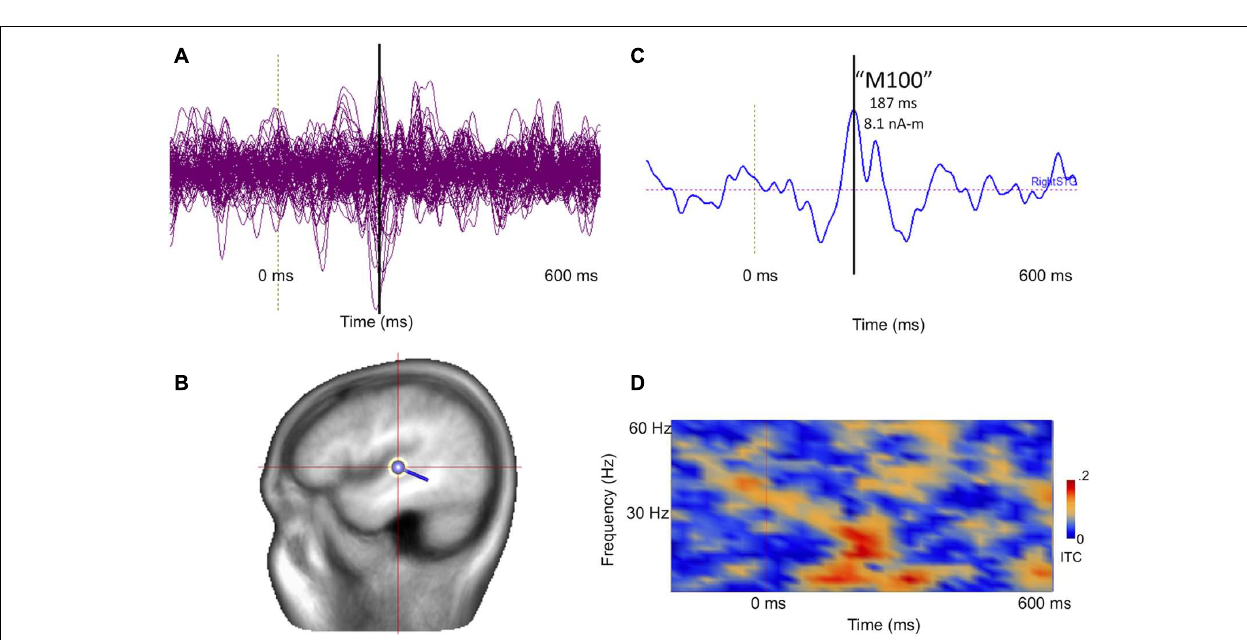
FIGURE 8 | (A) Collapsed (“butterfly”) plot of MEG auditory evoked sensor waveforms for a 14-month-old participant experiencing stimulation with a 1000 Hz tone, showing data from all MEG channels with stimulus locked averaging from − 200 to 600 ms with respect to tone onset (filtered 3–40 Hz). (B) A dipolar regional source is shown for the right superior temporal gyrus in a standard head model. (C) Source time course of the right superior temporal